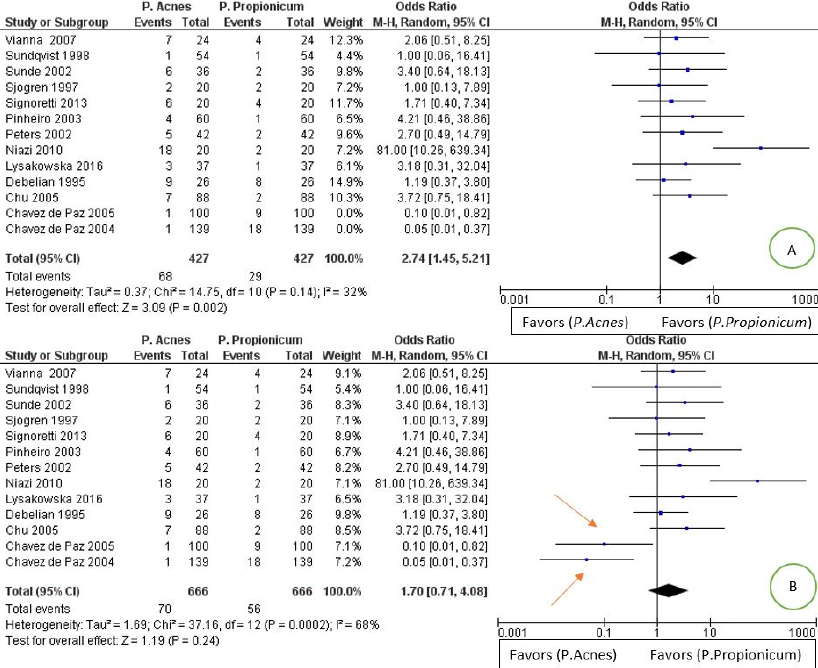
Figure 6. Forest plot of the fixed effects model of the meta-analysis of the secondary outcome.